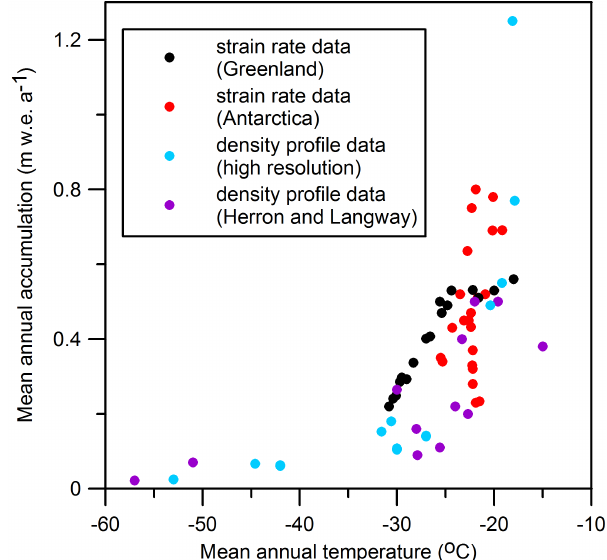
Figure 2. Mean annual temperature and accumulation at sites for which strain rate data are available (in Greenland [16] and Antarctica [8]), where high-resolution (gamma-ray) core-density profiles are available [7], and where the cores used to calibrate the Herron and Langway densificaton equation were collected